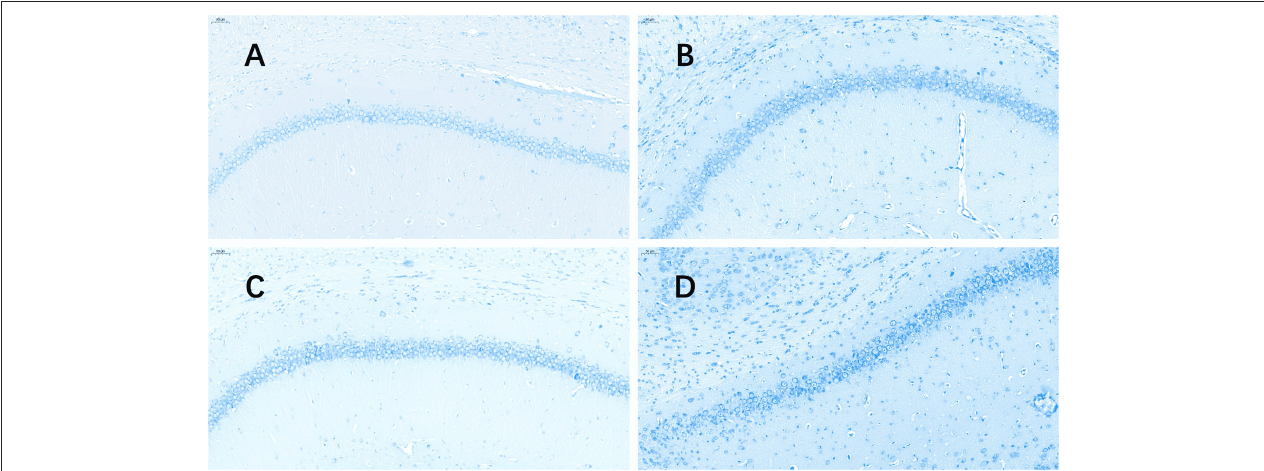
FIGURE 3 | TUNEL stained pictures of the hippocampus. The software nuclei quant automatically identified all the neurons with dark brown, claybank, and light yellow nuclei as positive and blue nuclei as negative. The positive rate was the apoptosis rate (%). (A) Plateau group, 24h after the last seizure; (B) plain group, 24h after the last seizure; (C) plateau group, 72h after the last seizure; (D) plain group, 72h after the last seizure (20.0 × ).